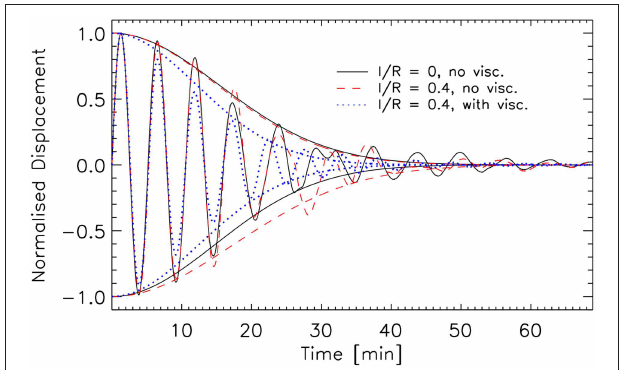
FIGURE 4 | Displacement of the loop axis (at apex) with time. For each time step we define the center of the loop as the center of mass. The result over time is plotted for the loop with no initial boundary and no viscosity (black solid curve), with initial boundary layer and no viscosity (red dashed curve) and with initial boundary layer and viscosity (blue dotted curve). We also overlay the fits to the maxima and minima of each profile performed with a damped Gaussian function (see text for